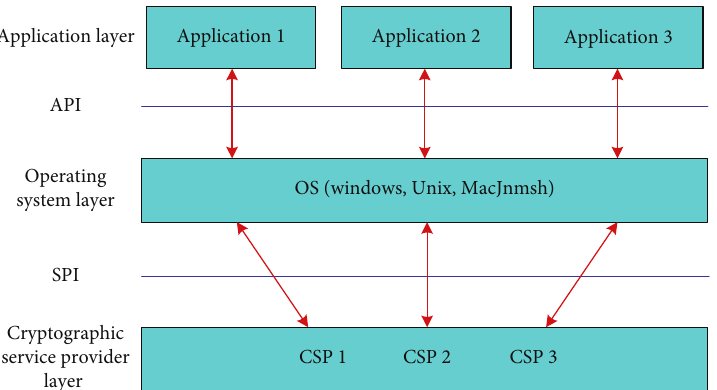
Figure 2: Architecture of CryptoAP1.